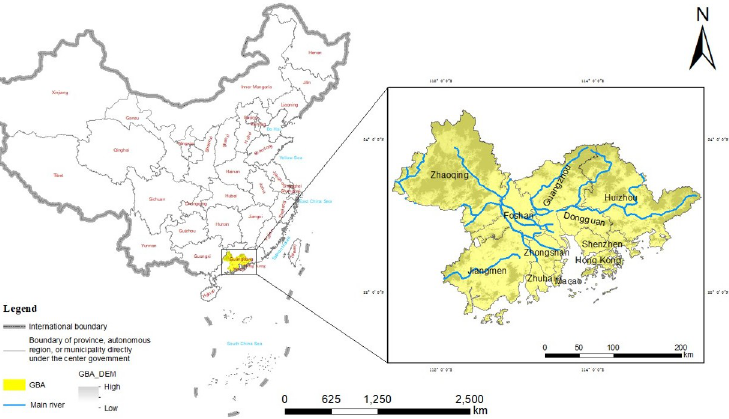
Fig 1. Location of the GBA in China. Reprinted background map from the National Catalogue Service for Geographic Information (www.webmap.cn) under a CC BY license, with permission from the National Geomatics Center of China, original copyright